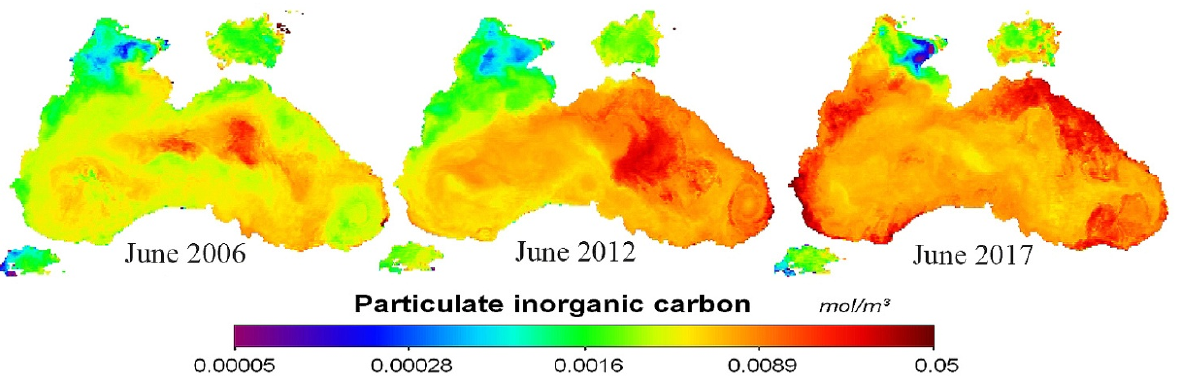
Figure 4. Distribution of suspended inorganic carbon in the Black Sea during the coccolithophore blooms in June 2006, 2012, 2017 according to the MODIS-Aqua (monthly average data).